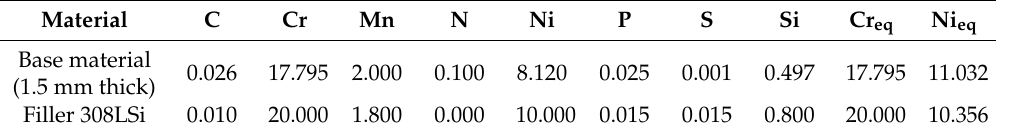
Table 1. Chemical composition of the materials used in the experiments.